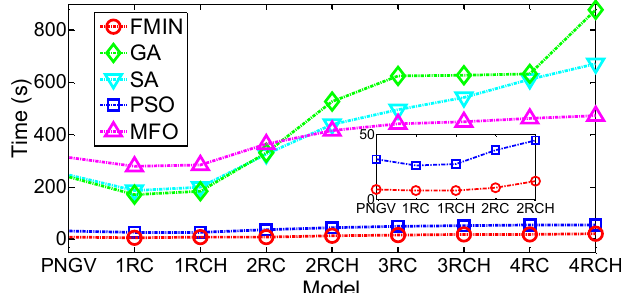
Figure 6. Comparison of identification time.